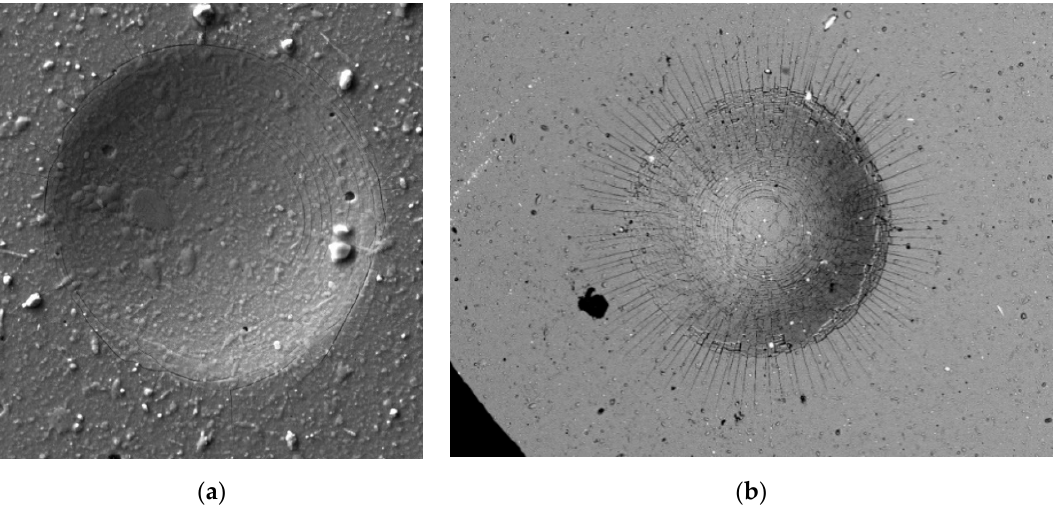
Figure 1. Coating cracks after indentation: ( a ) Circumferential cracks; ( b ) channel cracks and radial cracks.